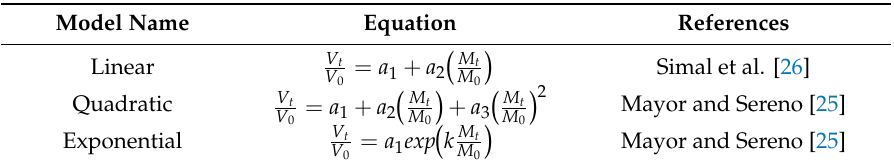
Table 2. Shrinkage